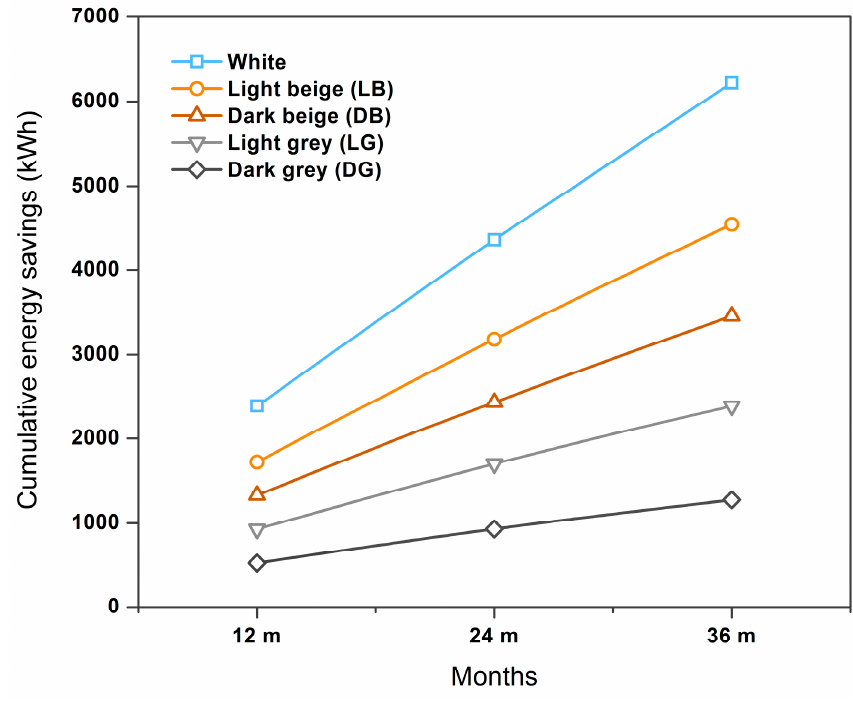
Figure 19. Effect of cool wall colors on 3 year cooling energy savings. Table 7. Year after year energy saving reduction for townhouse retrofitted with high SRI